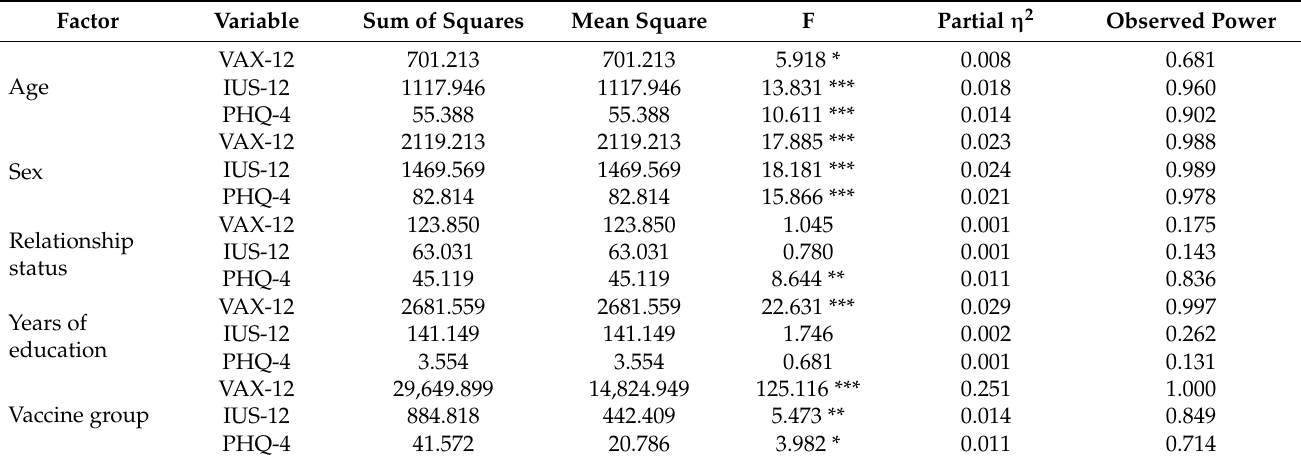
Table 4. MANCOVA results of the study